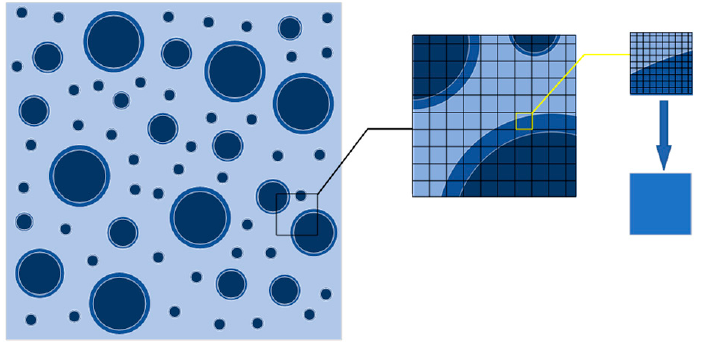
Figure 4. Mesoscopic model of regenerated concrete meshes.